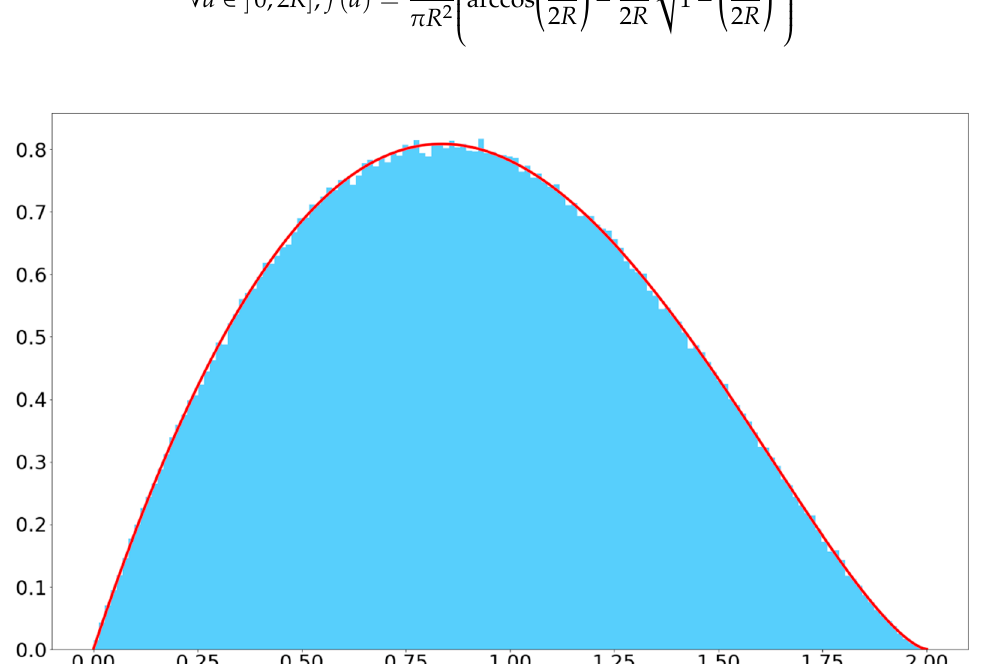
Figure 2. Distribution of inter-distances inside the unit circle (R = 1) for independently and uniformly distributed set of points. In red, the curve for the theoretical probability density function; in light blue, a simulated distribution from values generated by a homogeneous Poisson model with density ρ = 1500 inside the unit circle.